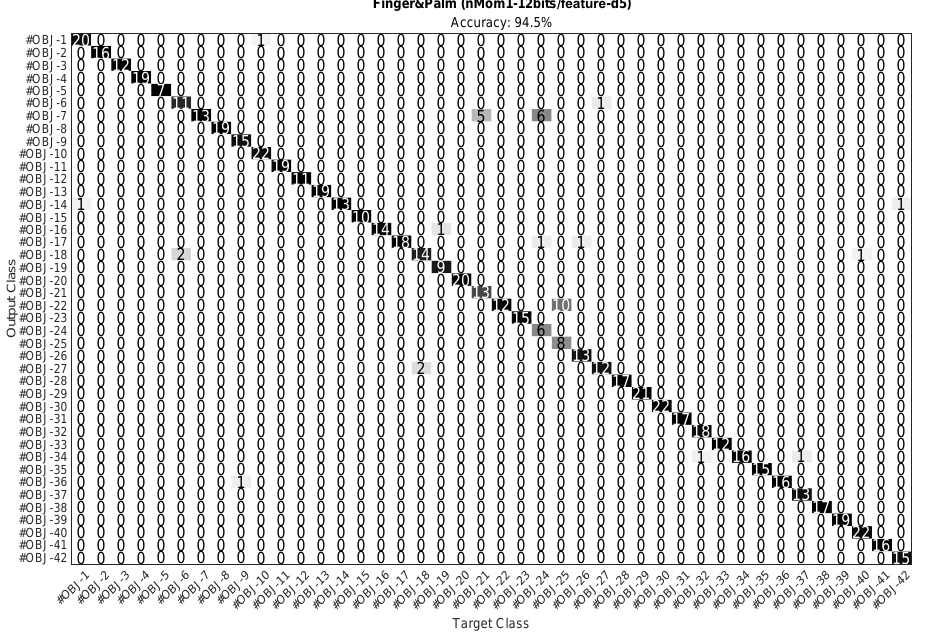
Figure 11. Confusion matrix of the optimal implementation in Figure 10. This case (second row of Table 4) used the first raw moment M 0,0 for both finger and palm, the d5 feature, and 12 bits per